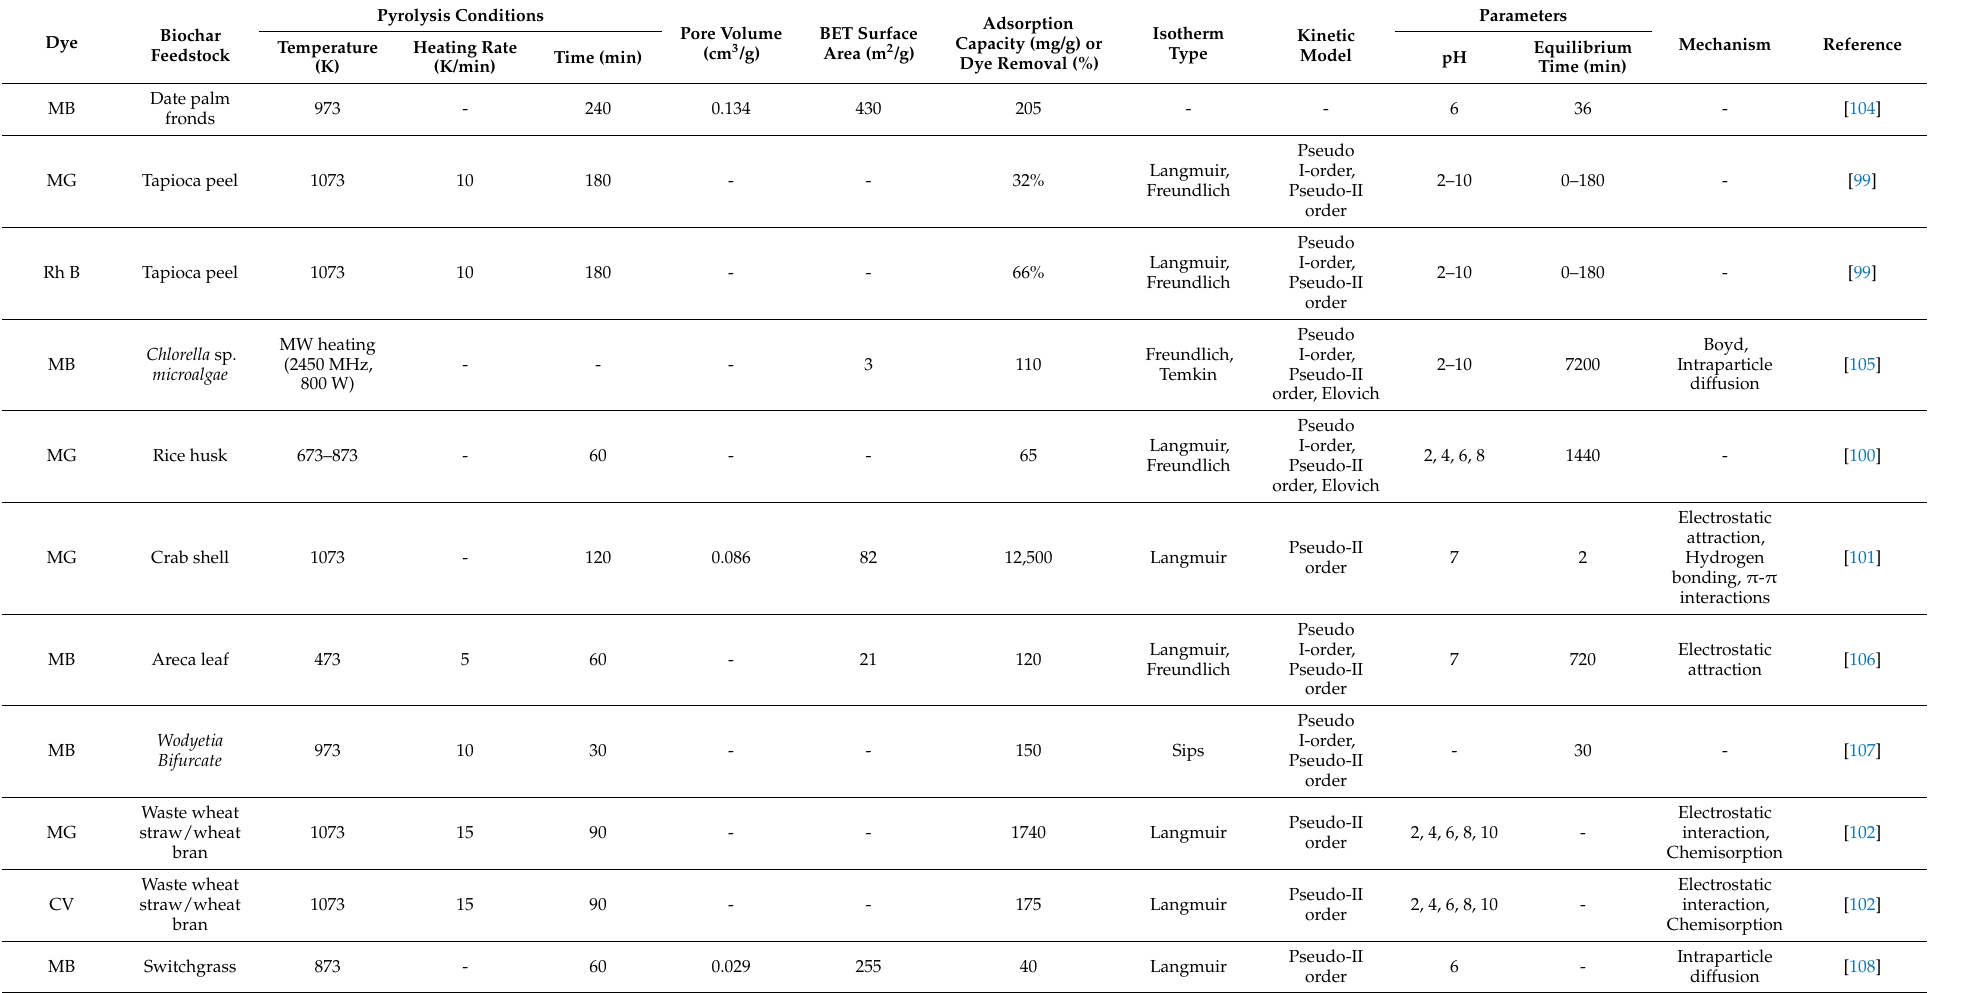
Table 1. Basic dyes (cationic) and their adsorption onto